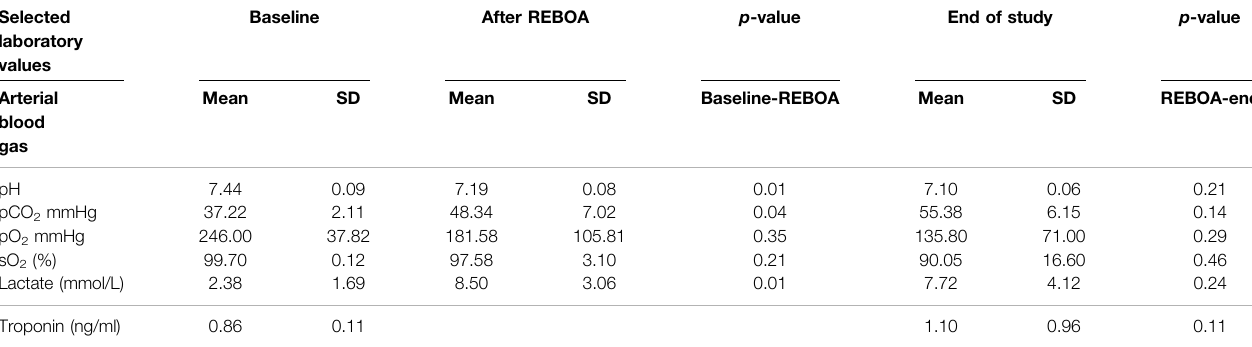
TABLE 1 | Selected study clinical laboratory values. Arterial Blood Gas (ABG) and Troponin from each study period, with comparisons between Baseline and Post-REBOA, and between Post-REBOA and the End of Study. Selected